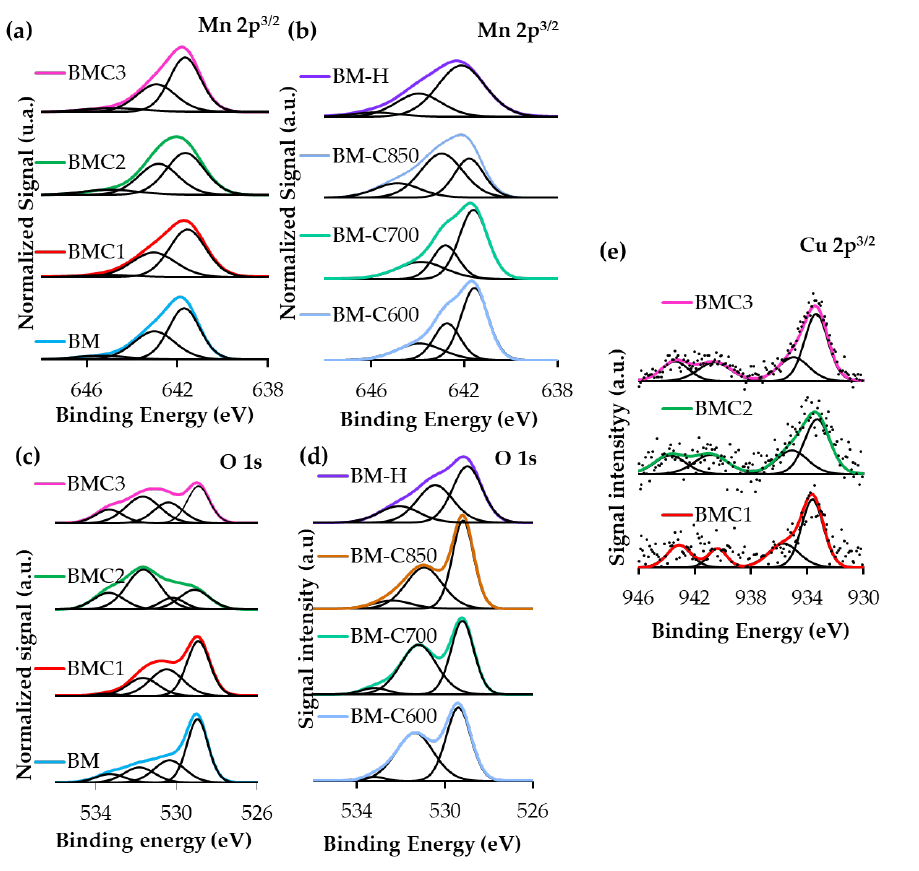
Figure 2. XPS transition spectra of Mn2p 3/2 ( a , b ), O1s ( c , d ) and Cu 2p 3/2 ( e ) for BaMn 1 − x Cu x O 3 and BaMnO 3 catalyst series.